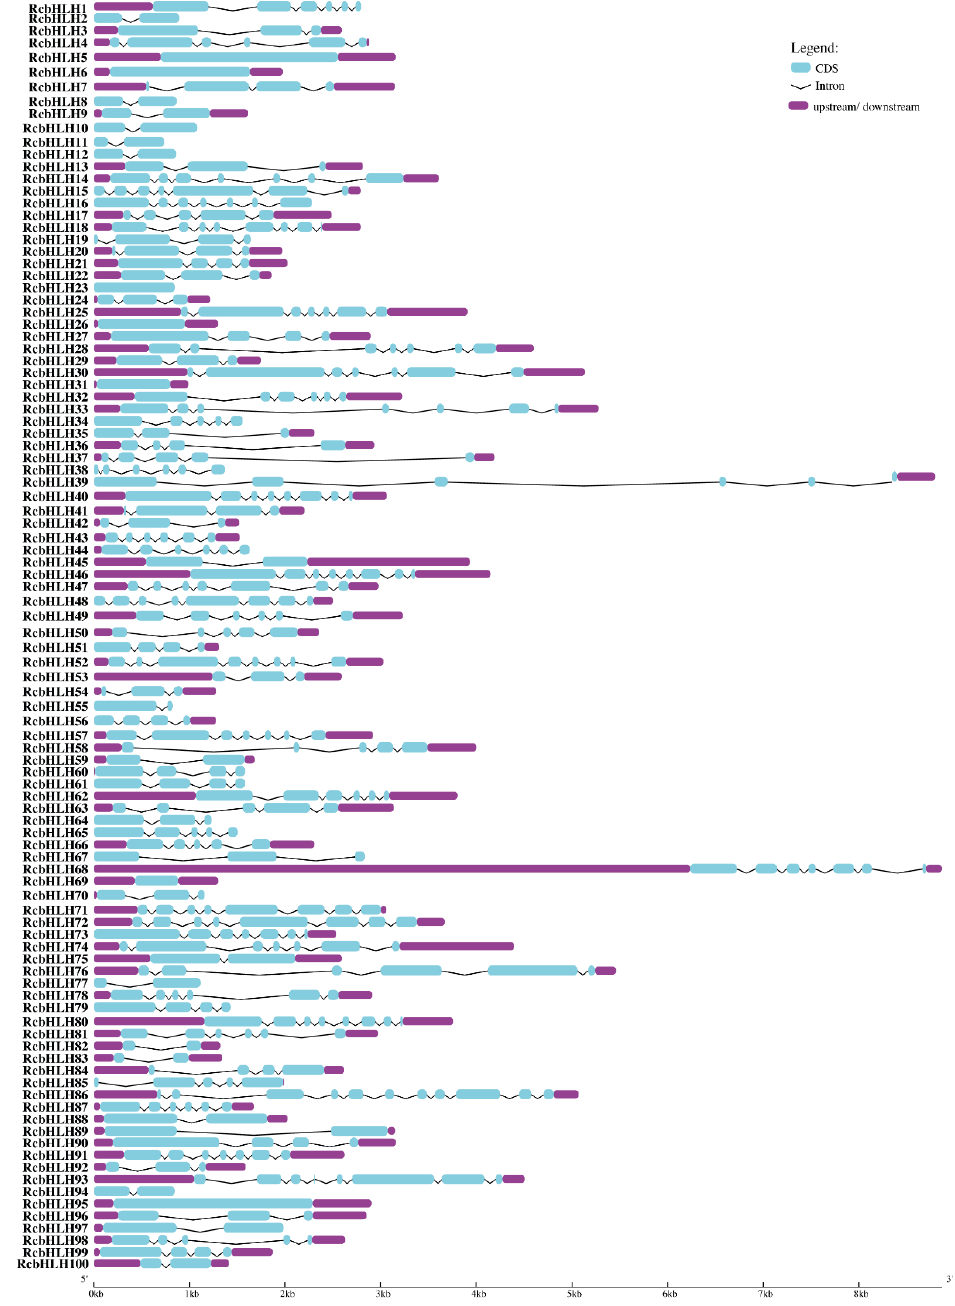
Figure 5. Gene structure analysis of identified RcbHLH gene members. Cyan shapes represent the CDS region, purple shapes showed the up and down stream regions, and black lines represent the introns.